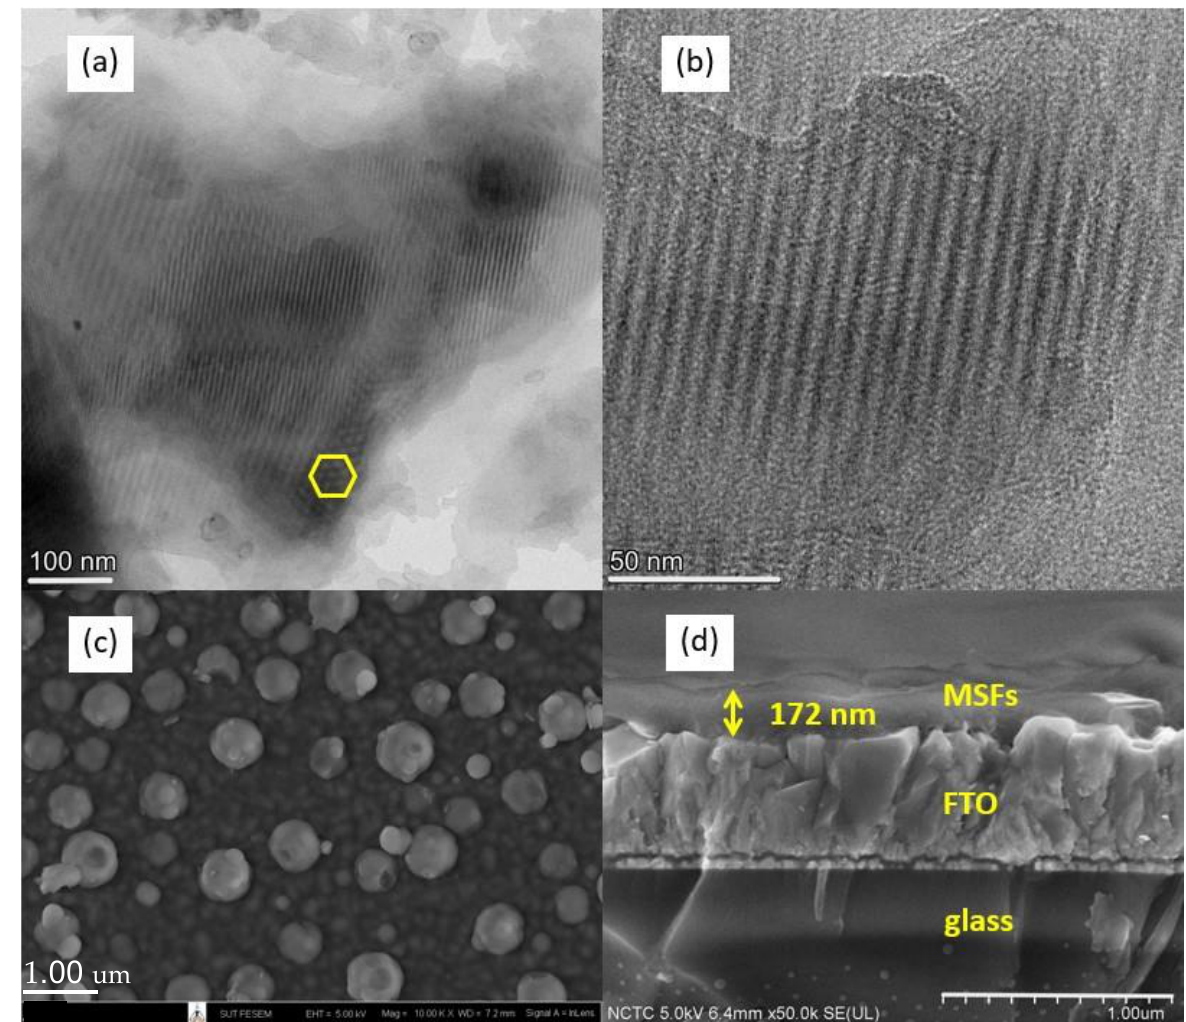
Figure 1. TEM images of mesoporous silica film stripped from the substrate ( a , b ). SEM images of the film on FTO glass, top view ( c ), and cross-sectional view ( d ) .